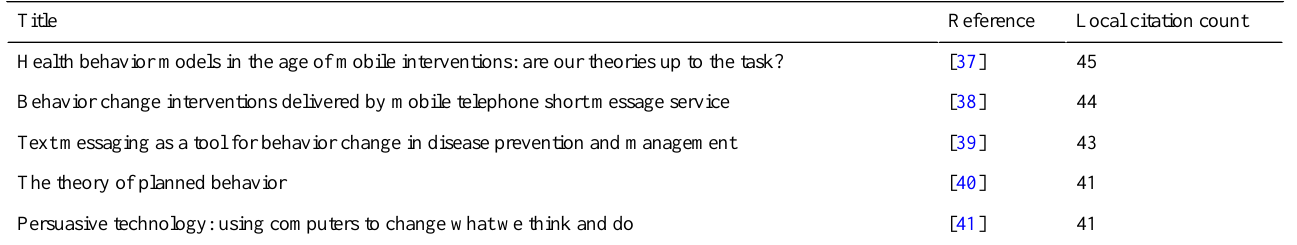
Table 4. Top 5 of the most citied articles within the network (locally).